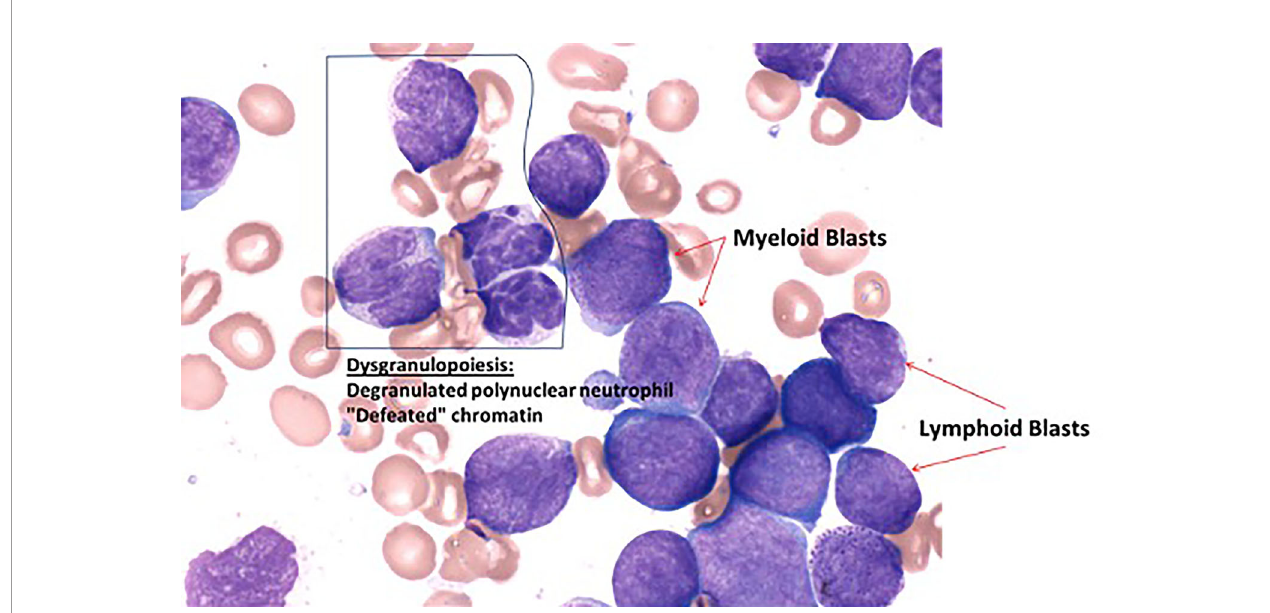
FIGURE 1 | Cytological features of the bone marrow at diagnosis (May-Grünwald